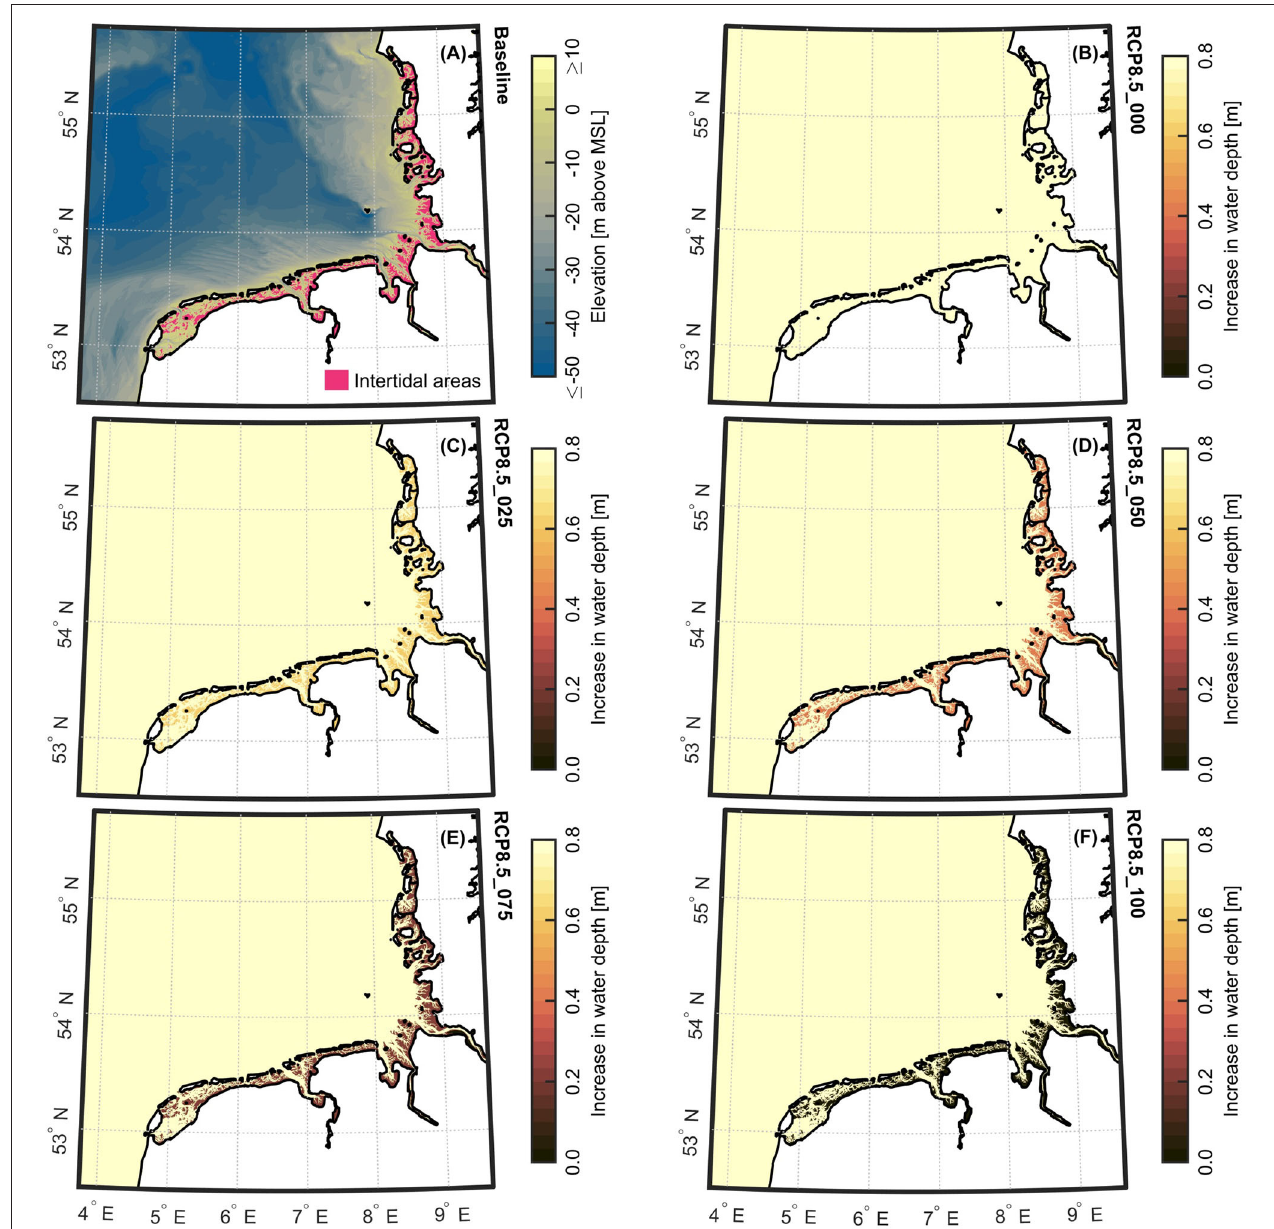
FIGURE 5 | Combinations of 0.8m SLR projection and various cumulative rates of vertical accretion in the Wadden Sea. (A) Bathymetric map for the Wadden Sea, including locations of intertidal flats. Local increases in water depths for scenarios (B) RCP8.5_000, (C) RCP8.5_025, (D) RCP8.5_050, (E) RCP8.5_075, and (F)